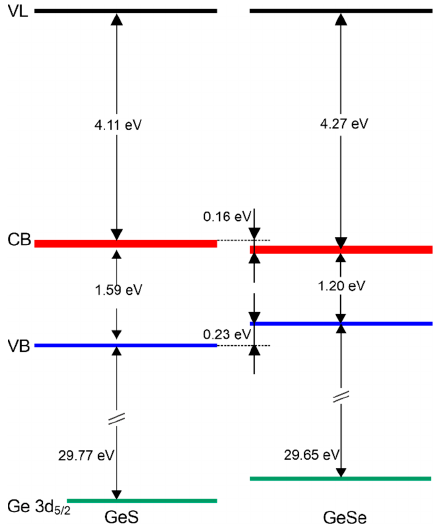
Figure 6. Band energy diagrams for GeS and GeSe samples. The valence and conduction band off- sets are 0.16 eV and 0.23 eV, respectively. Abbreviations: VL—vacuum level; CB—position of con- duction band minimum; VB—position of valence band maximum.